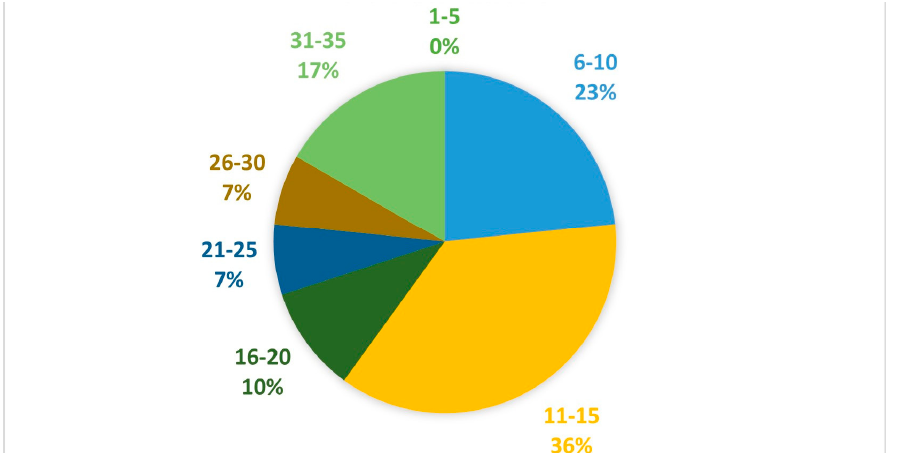
Figure 4. Experience of respondents in years.